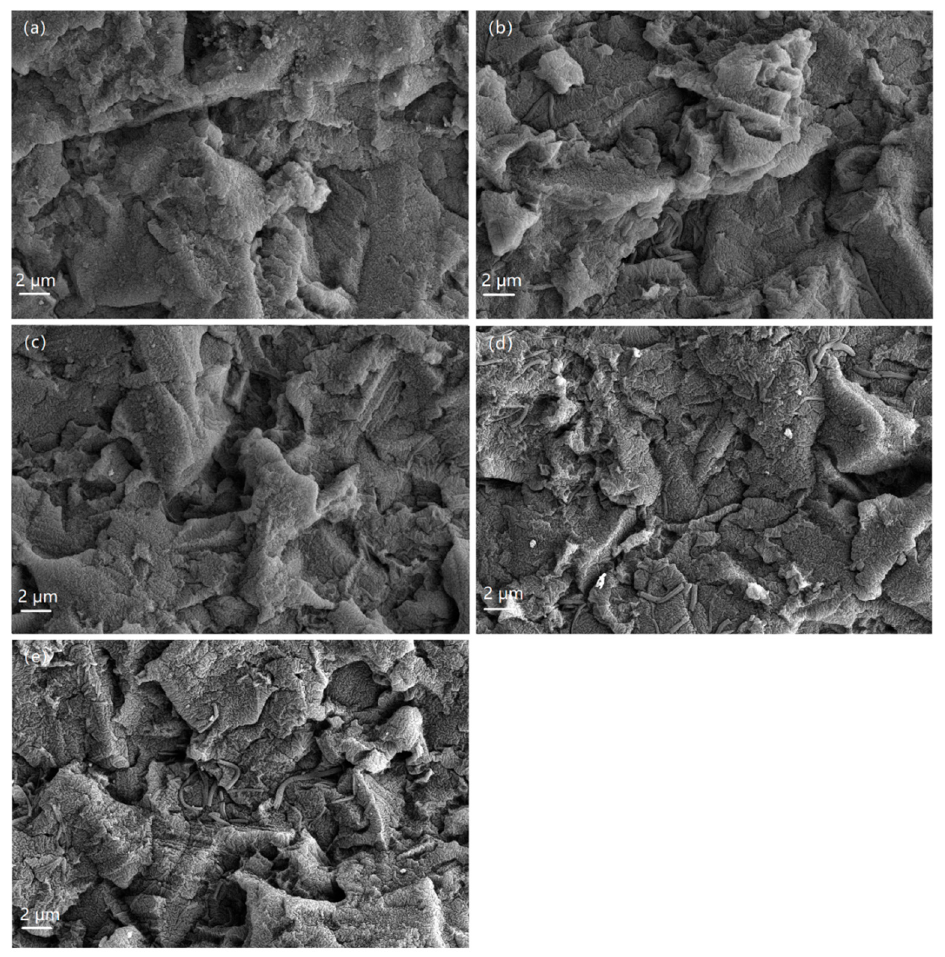
Figure 2. SEM micrographs of the films deposited on substrates. ( a ) Specimen 1; ( b ) Specimen 2; ( c ) Specimen 3; ( d ) Specimen 4; ( e ) Specimen 5.